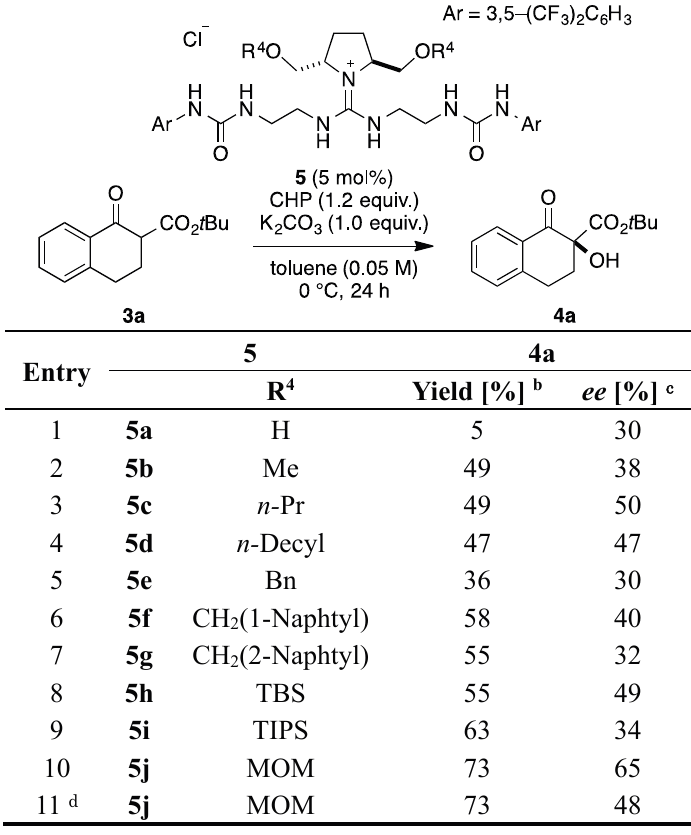
Table 1. Investigation of α -hydroxylation of 3a using 5 a